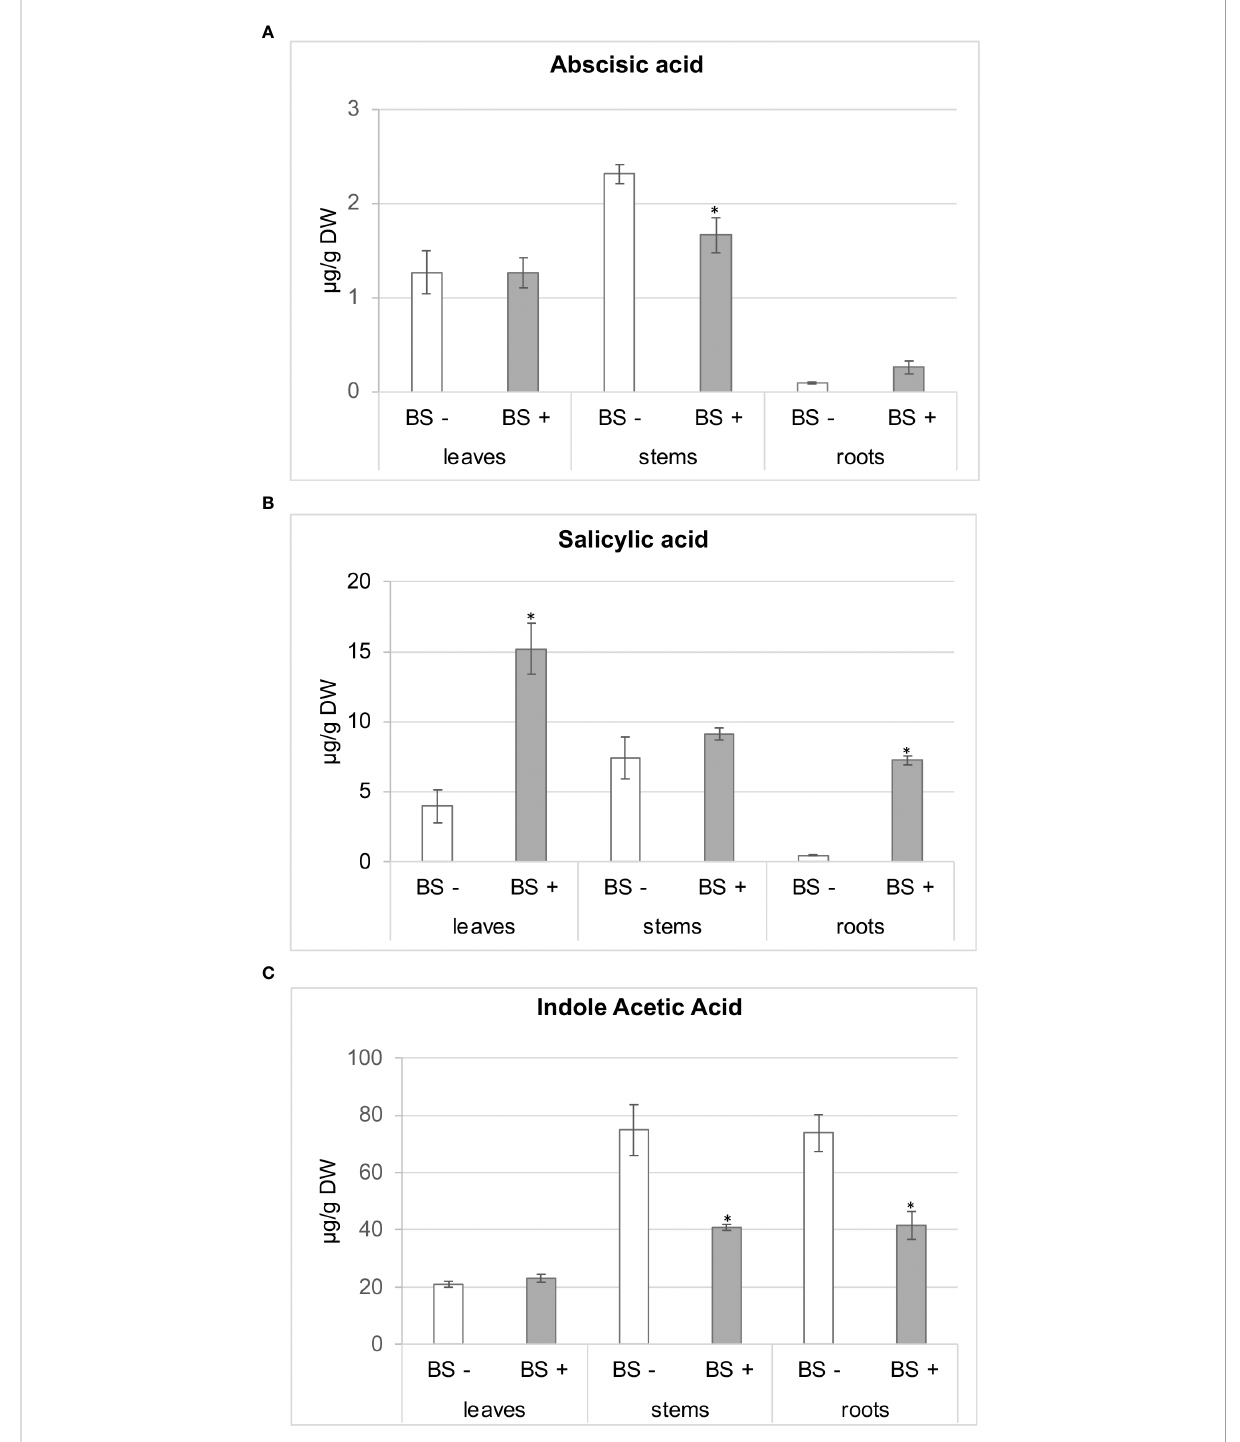
FIGURE 5 Effect of BS treatment on abscisic acid (ABA), salicylic acid (SA), and indole acetic acid (IAA) contents of grapevine plantlet leaves, stems and roots. Micro-cuttings were transplanted in a solid culture medium supplemented with BS 0.1% (v/v, “ BS+ ” ) or water ( “ BS- ” , as control). At 4 wpt, plantlets were collected and dissected to distinct leaf, stem and root samples. Extracts were prepared, and ABA (A) , SA (B) , IAA (C) were analyzed by LC-MS. Signi fi cant differences were identi fi ed with Kruskall-Wallis test with * P <